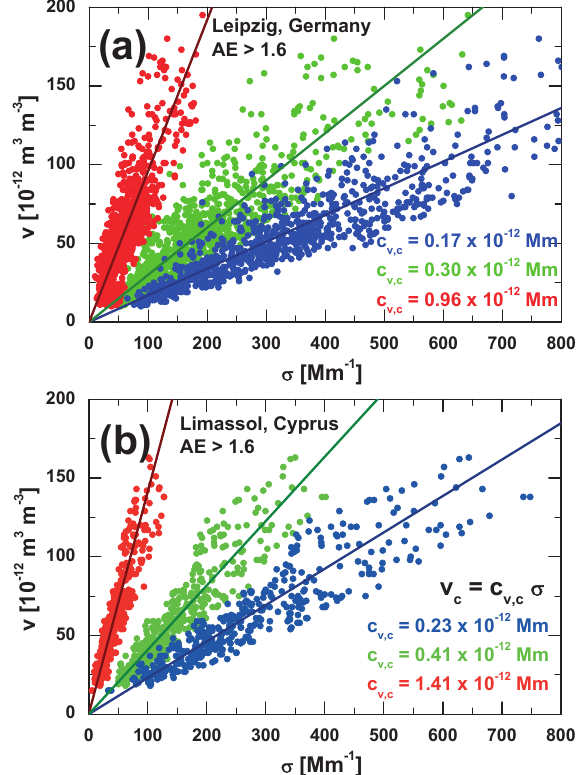
Figure 4. Same as Fig. 3 except for cases dominated by fine-mode aerosol pollution measured at (a) Leipzig (974 observations in the period from May 2001 to June 2015) and (b) Limassol (421 obser- vations in the period from July 2011 to June 2015). Correlations and mean conversion factors are shown for the laser wavelengths of 355 (blue), 532 (green), and 1064nm (red). Conversion factors are given as numbers and also listed in Table